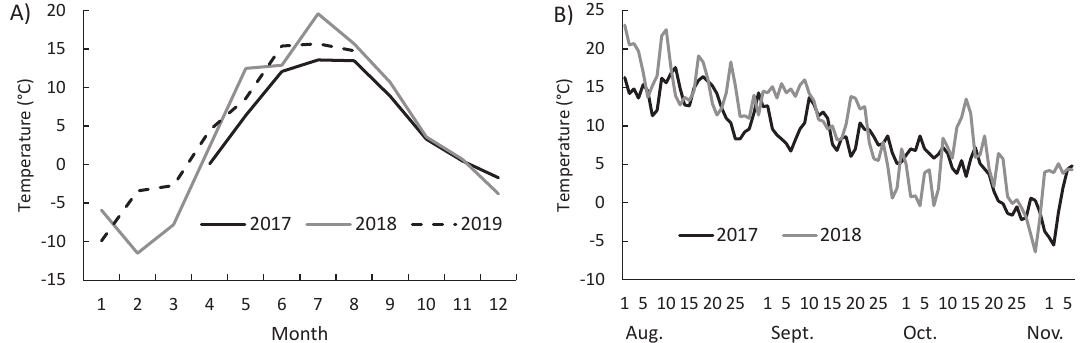
Fig. 1. Monthly average temperatures during the experiments in 2017 to 2019 (A) and daily average temperatures during August through 6 November in 2017 and 2018 (B) recorded in Ähtäri (Finnish Meteorological Institute,